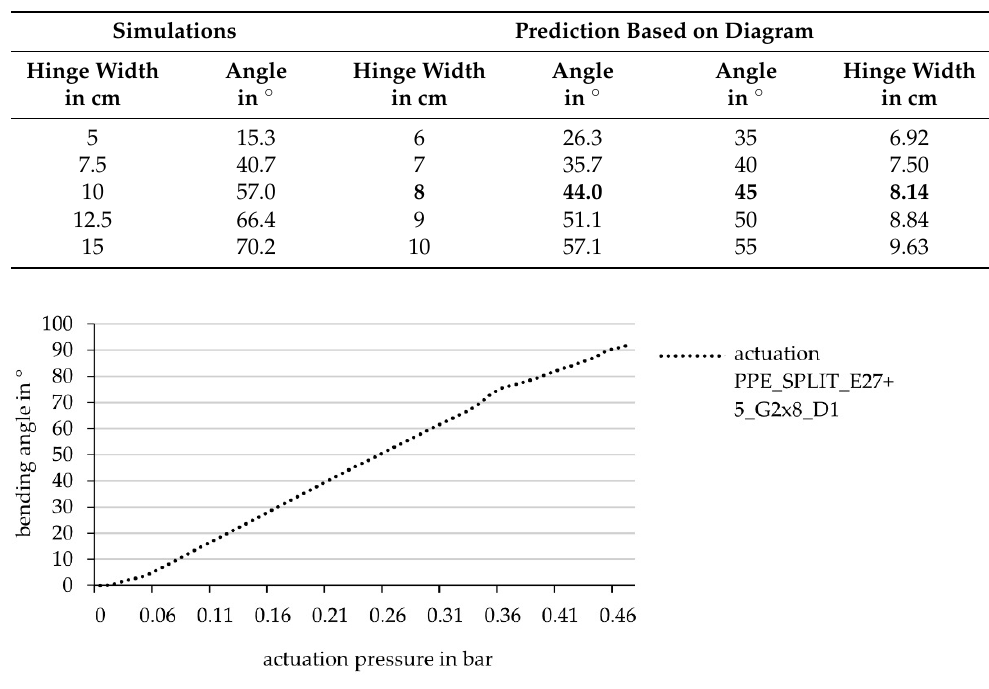
Figure 14. Results of simulative testing of an element with two hinges (hinge width 8 cm, distance between hinges 1 cm), bending angle in relation to actuation pressure.